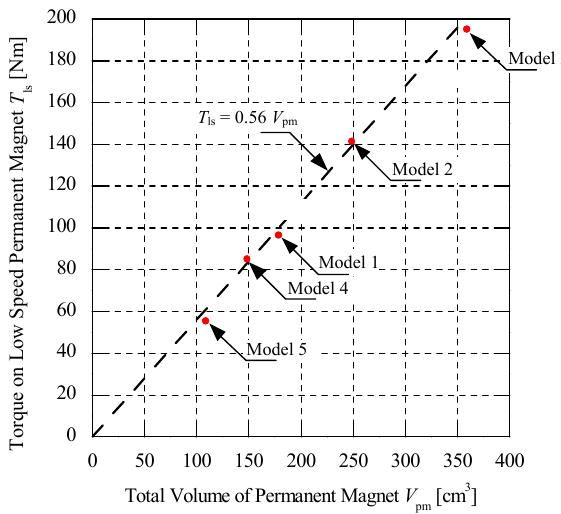
Figure 6. The simulated result of the models on the Maximum Transmission Torque Line (MTTL).